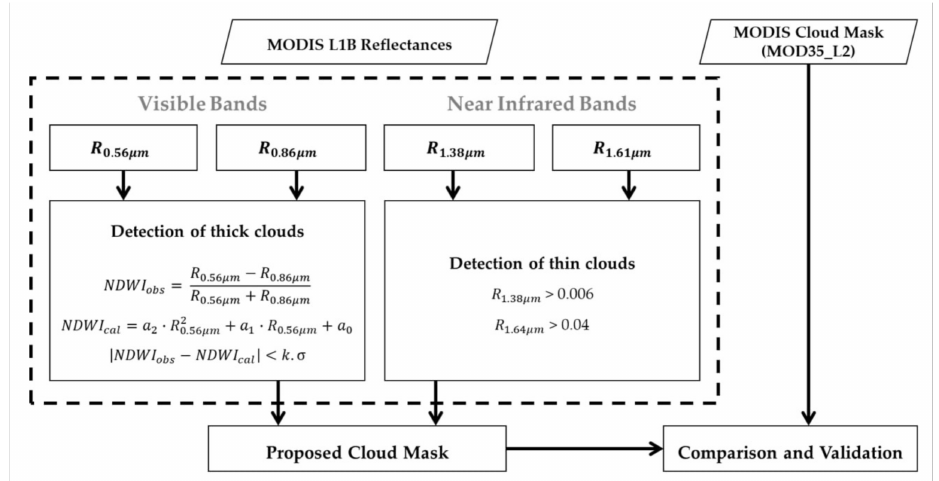
Figure 3. Flowchart of the proposed cloud detection